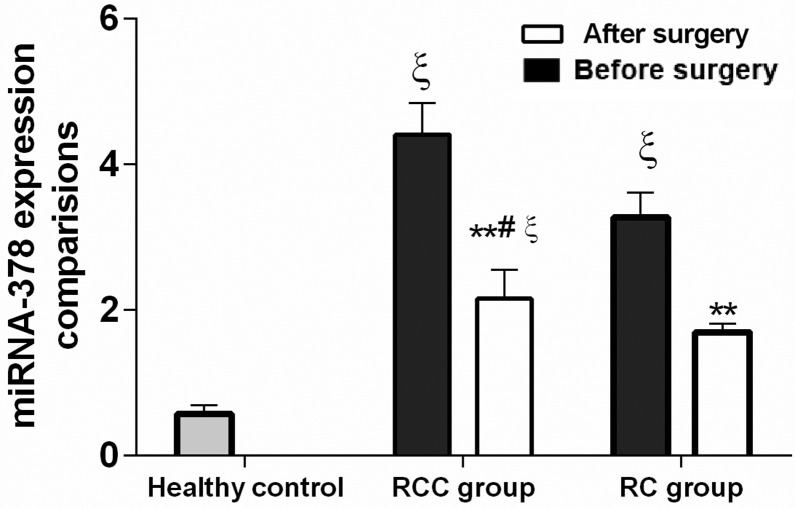
Comparison of miRNA-378 expressions among healthy controls, renal cyst (RC)
and renal cell carcinoma (RCC) patients before surgery and six months after
surgery. **p < 0.01 compared with before surgery in same group;
#p < 0.05, compared with RC group after surgery. ξ P < 0.01
compared with healthy subjects.